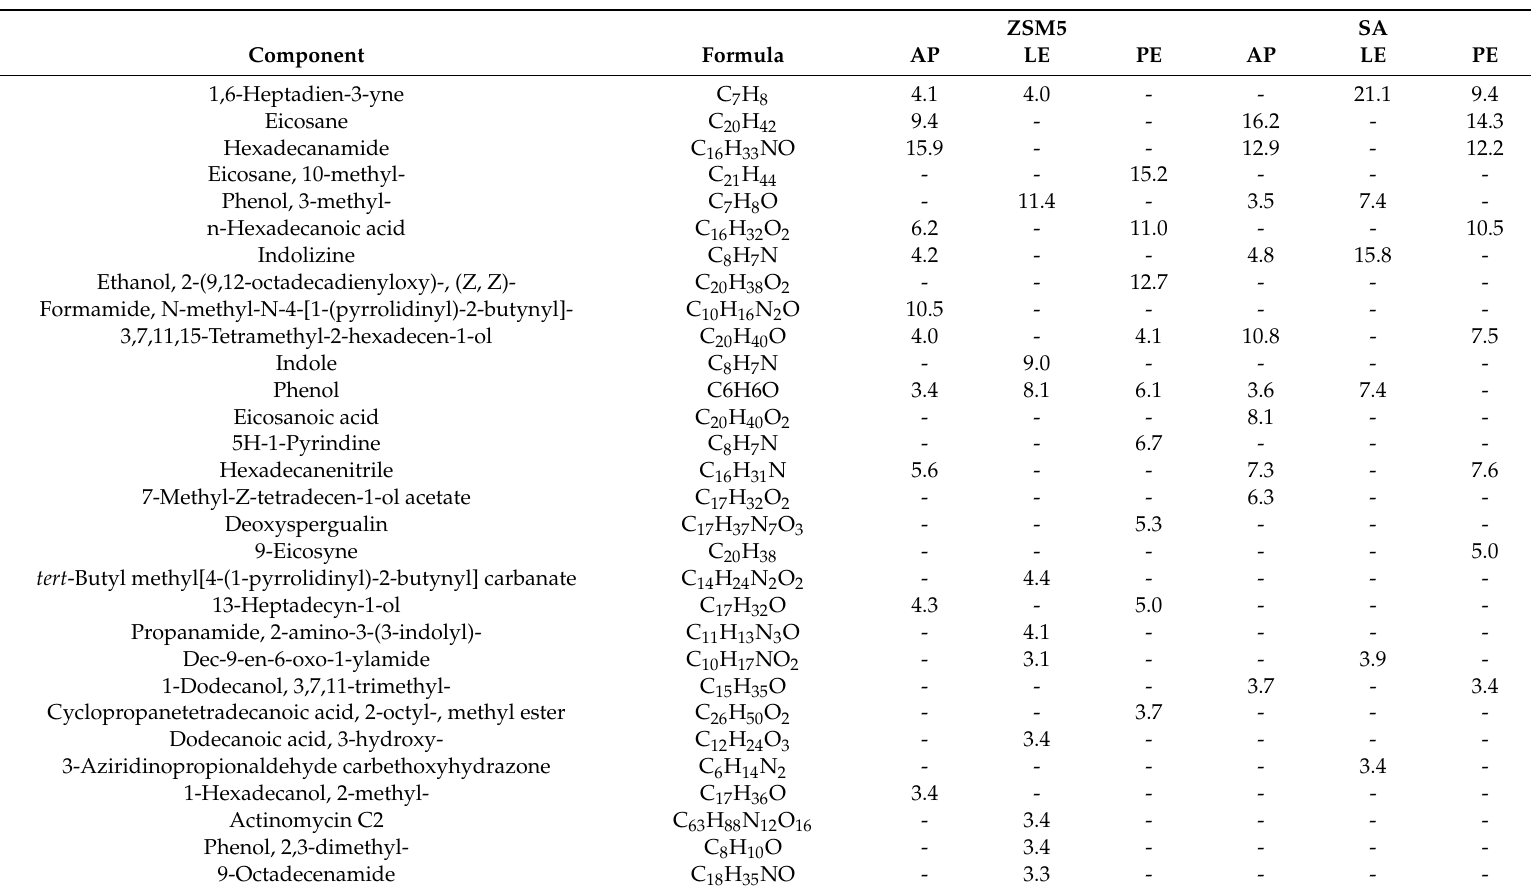
Table 3. Percentage composition (%) of light reaction liquids (LLs) from catalytic pyrolysis using ZSM5 or silica–alumina as catalyst in terms of individual compounds. Analytical determinations were made by GC–MS on LLs from untreated Arthrospira platensis biomass (AP), biomass after lipid extraction (LE), biomass after protein extraction